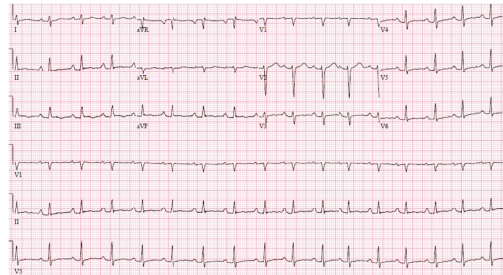
Figure 5: After antibiotic therapy, resolution of AV